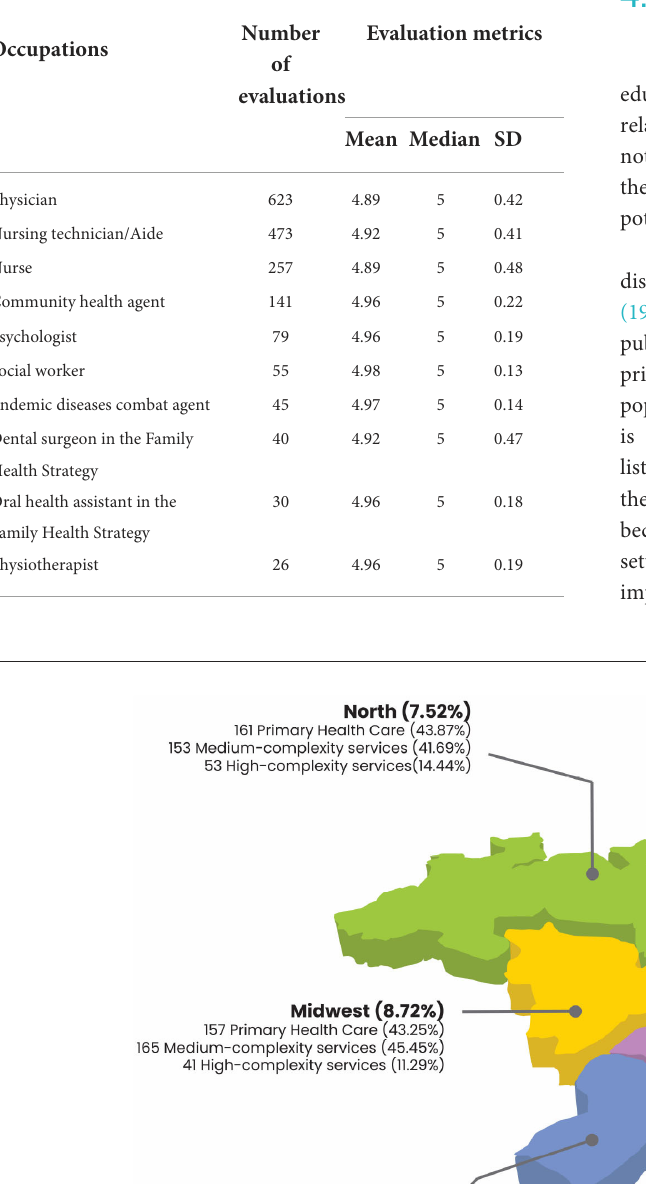
TABLE 1 Evaluation by course participants according to occupation.